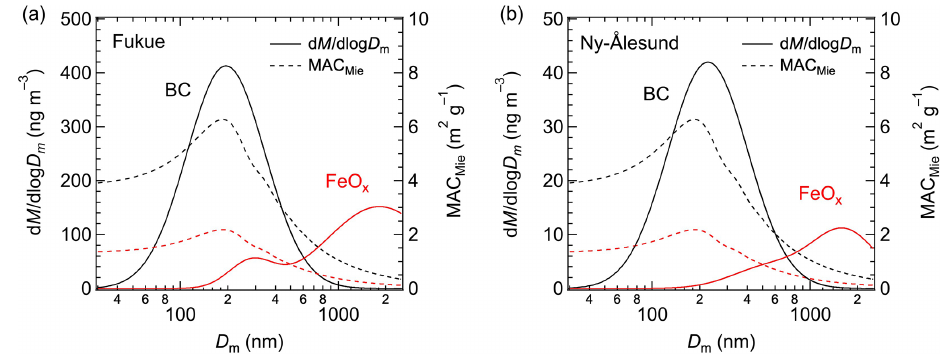
Figure 2. Mass size distributions of BC (black line) and FeO x (red line) and mass absorption cross sections calculated by Mie theory for bare BC (black dashed line) and bare FeO x (red dashed line) at (a) Fukue in April 2019 and (b) Ny-Ålesund in March 2017. D m is the mass-equivalent diameter of bare BC or FeO x . Assumptions for the Mie calculations are given in Sect.